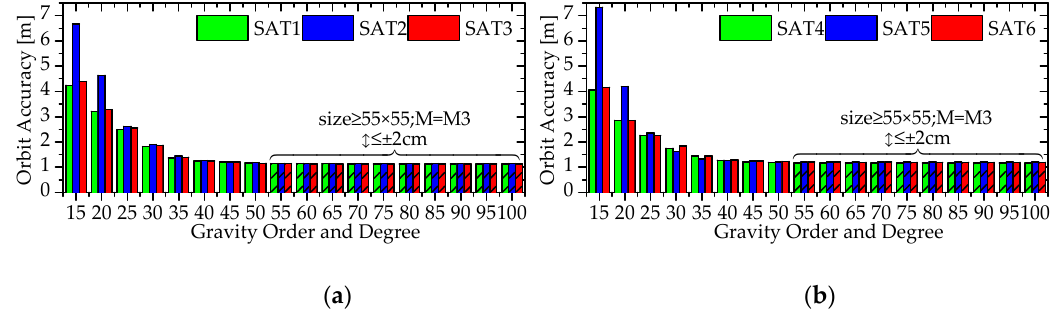
Figure 5. Comparison of real-time orbit accuracies of the YG30/SAT1-SAT6 satellites under different force models: ( a ) The position accuracy of the SAT1-SAT3 satellites; ( b ) The position accuracy of the SAT4-SAT6 satellites.